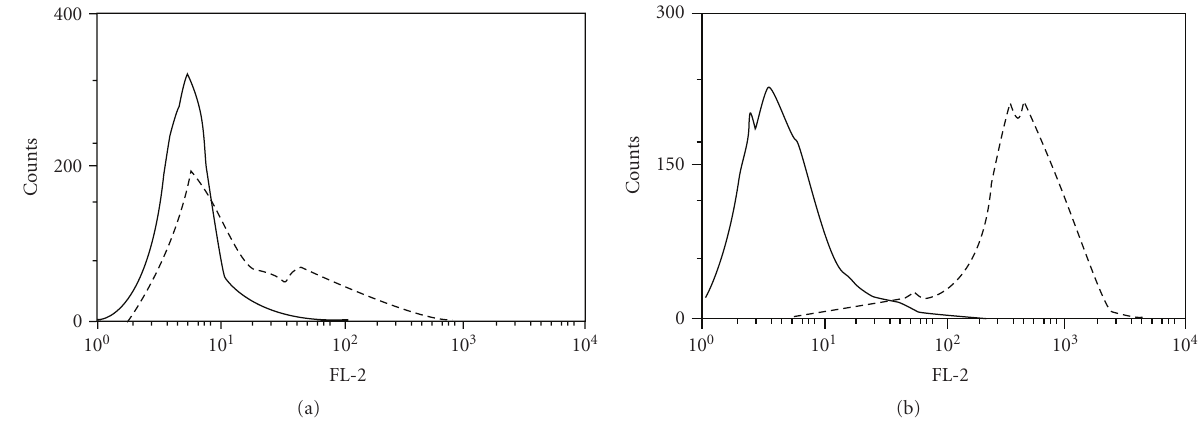
Figure 3: AIDS-NHL cell lines express CXCR5, as shown by flow cytometry. The AIDS-BL cell line, 2F7 (a), and the AIDS-DLBCL cell line, R (b), were stained for CXCR5 expression using an indirect staining protocol, as noted in Section 2. First, cells were stained with a rat anti-CXCR5 antibody (dotted lines). As a control, some cells were stained with a rat IgG IgG 2b were then stained with a PE-conjugated goat anti-rat IgG secondary antibody, and examined by flow cytometry. During the flow cytometry acquisition stage, at least 5,000 cells/events were acquired per tube/condition. During analysis, dead cells were excluded using forward- and